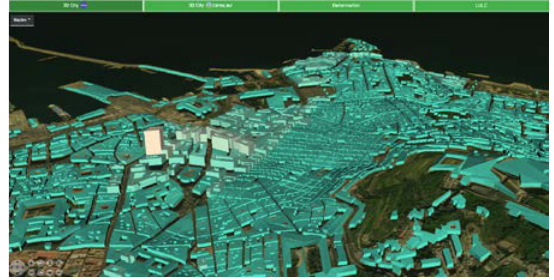
Figure 10. The Urban GEO BIG DATA client: